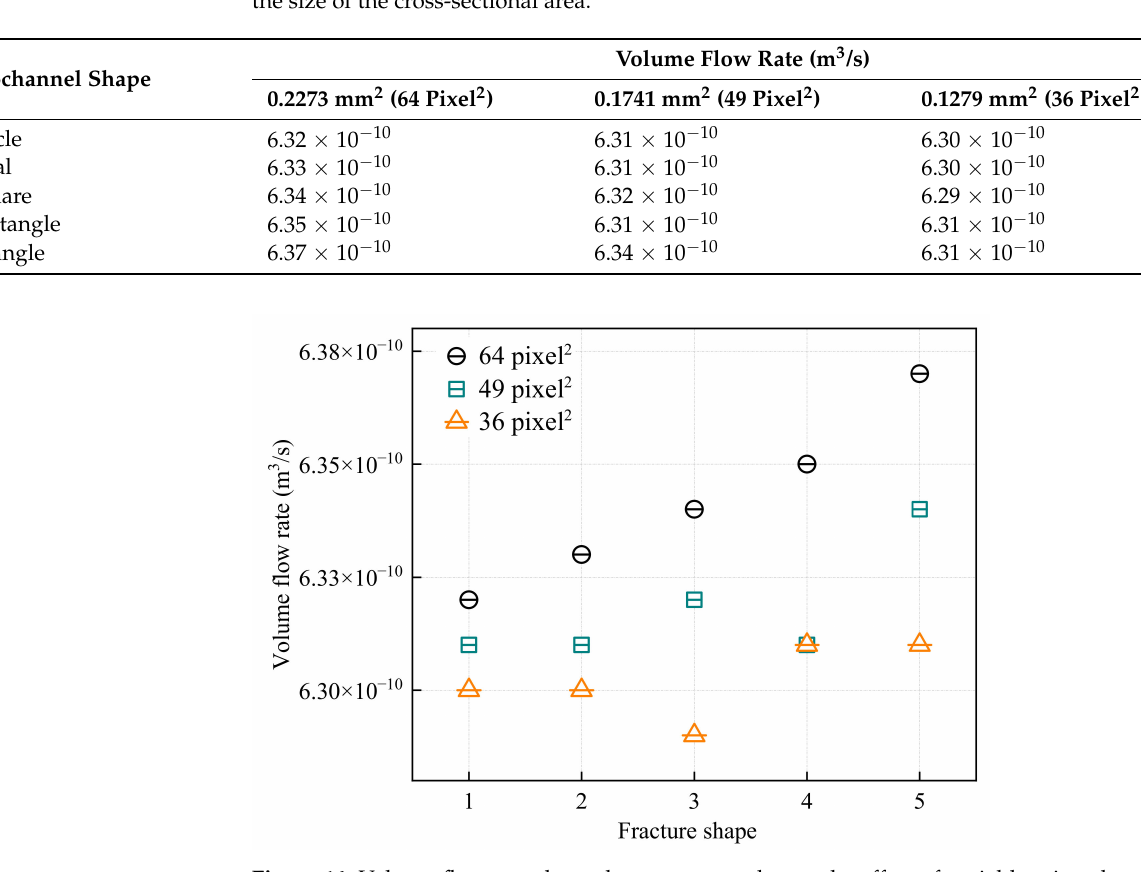
Figure 14. Volume flow rate through a cement–rock sample: effect of variable microchannel shape and cross-sectional area.